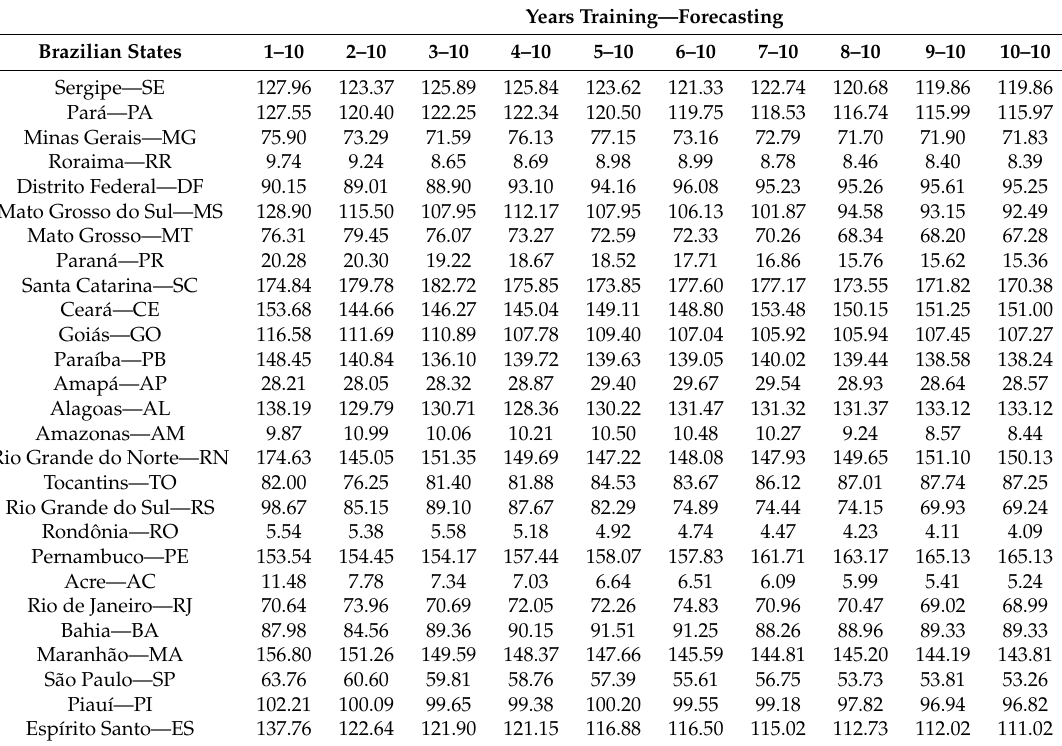
Table 3. RMSE Forecasting error for different training samples and durations in all Brazilian states. Years Training—Forecasting